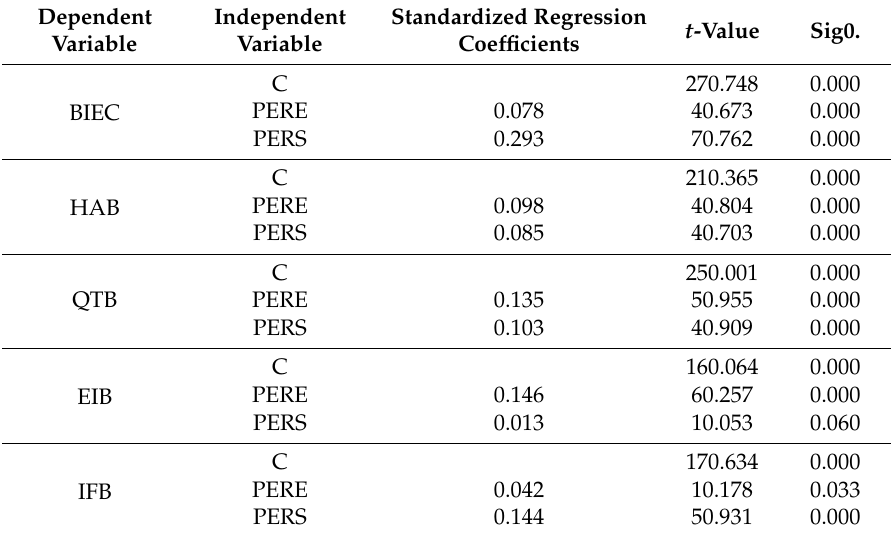
Table 6. Linear regression analysis of perception of energy conservation behavior